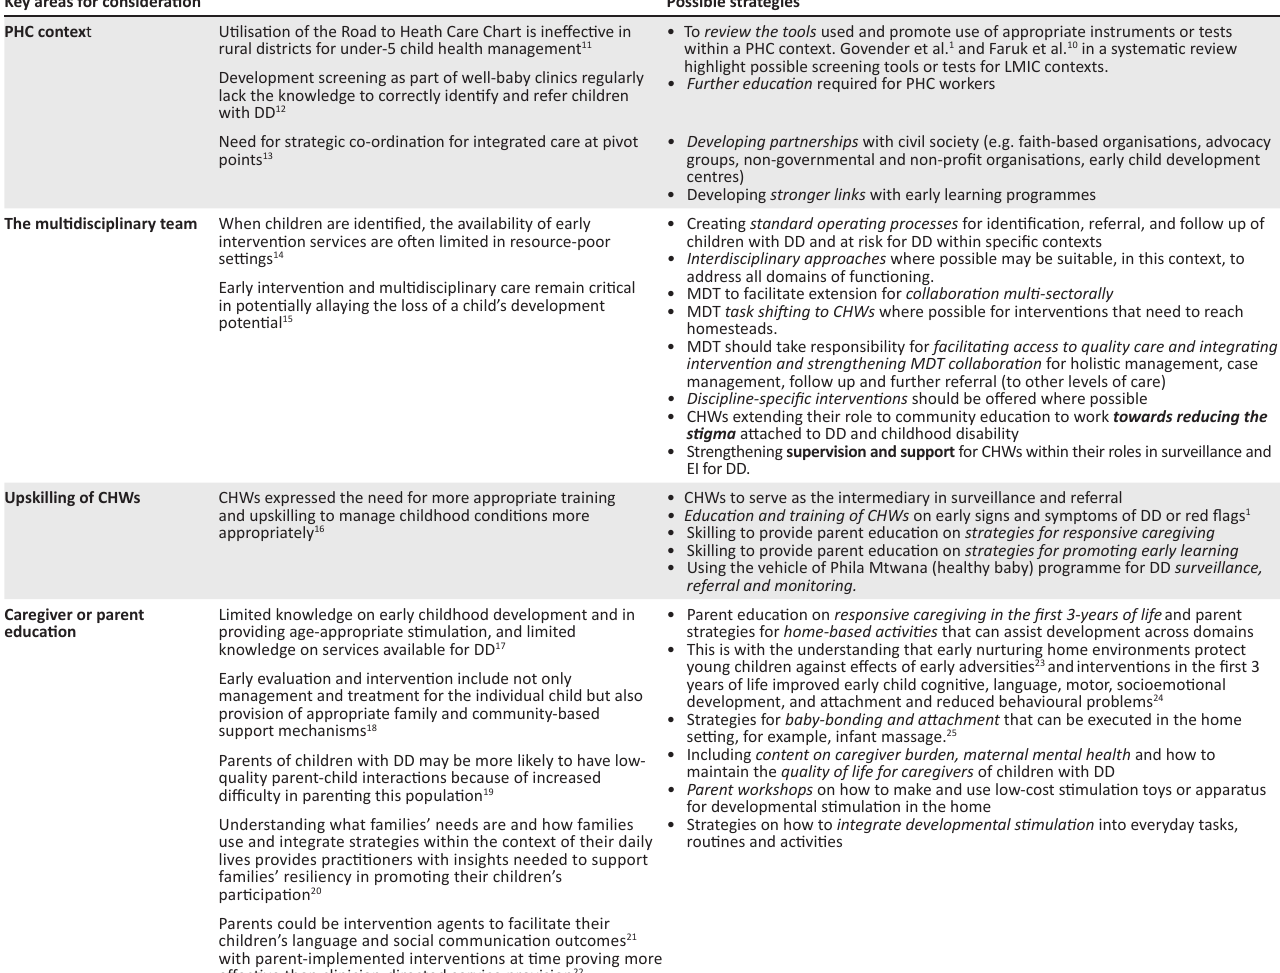
TABLE 1 : Promoting early intervention at a primary healthcare level. Key areas for consideration Possible strategies